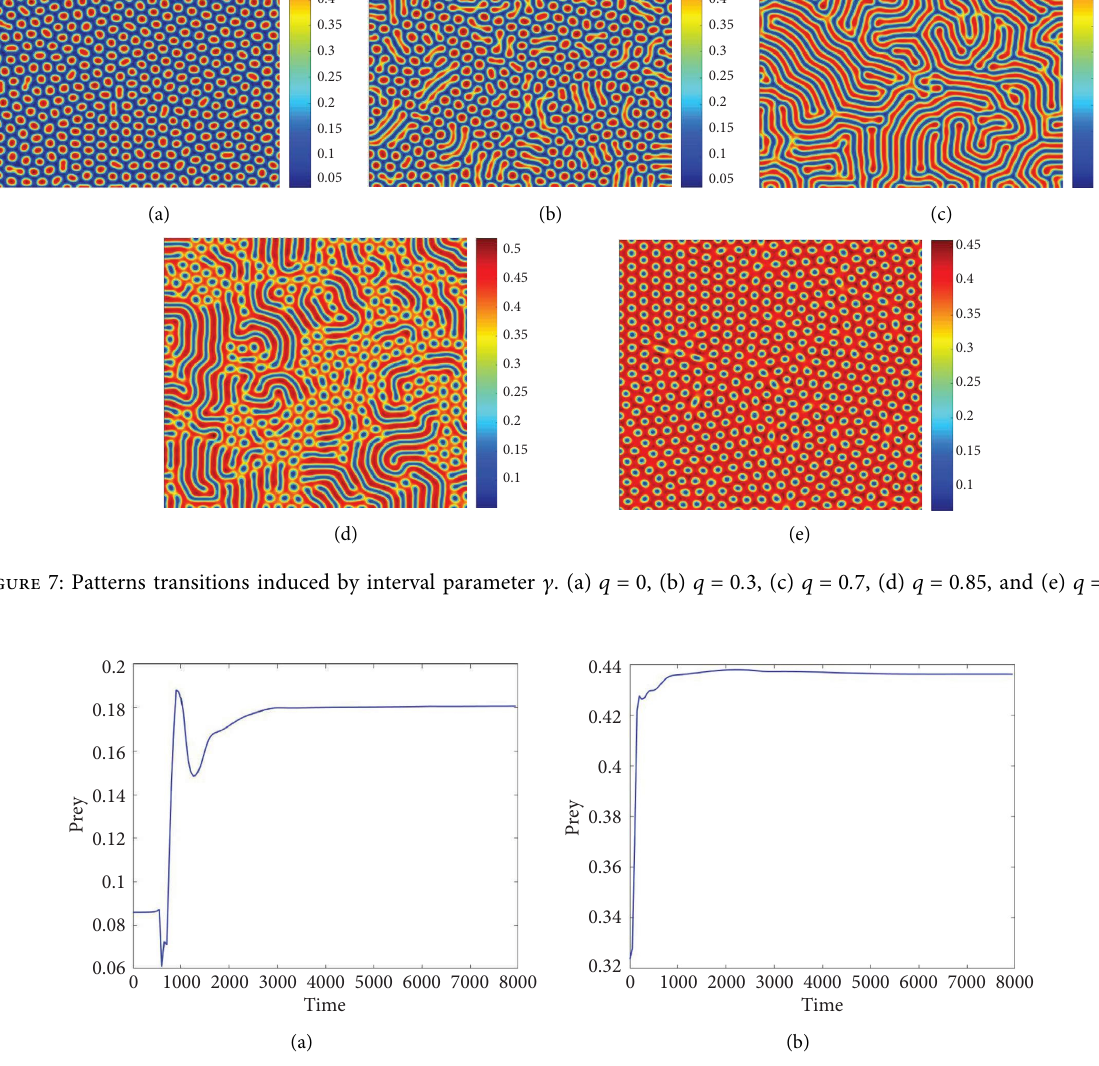
Figure 8: Time-series of prey’s density at spatial location ( 61 , 11 ) : (a) q � 0 and (b) q � 1.